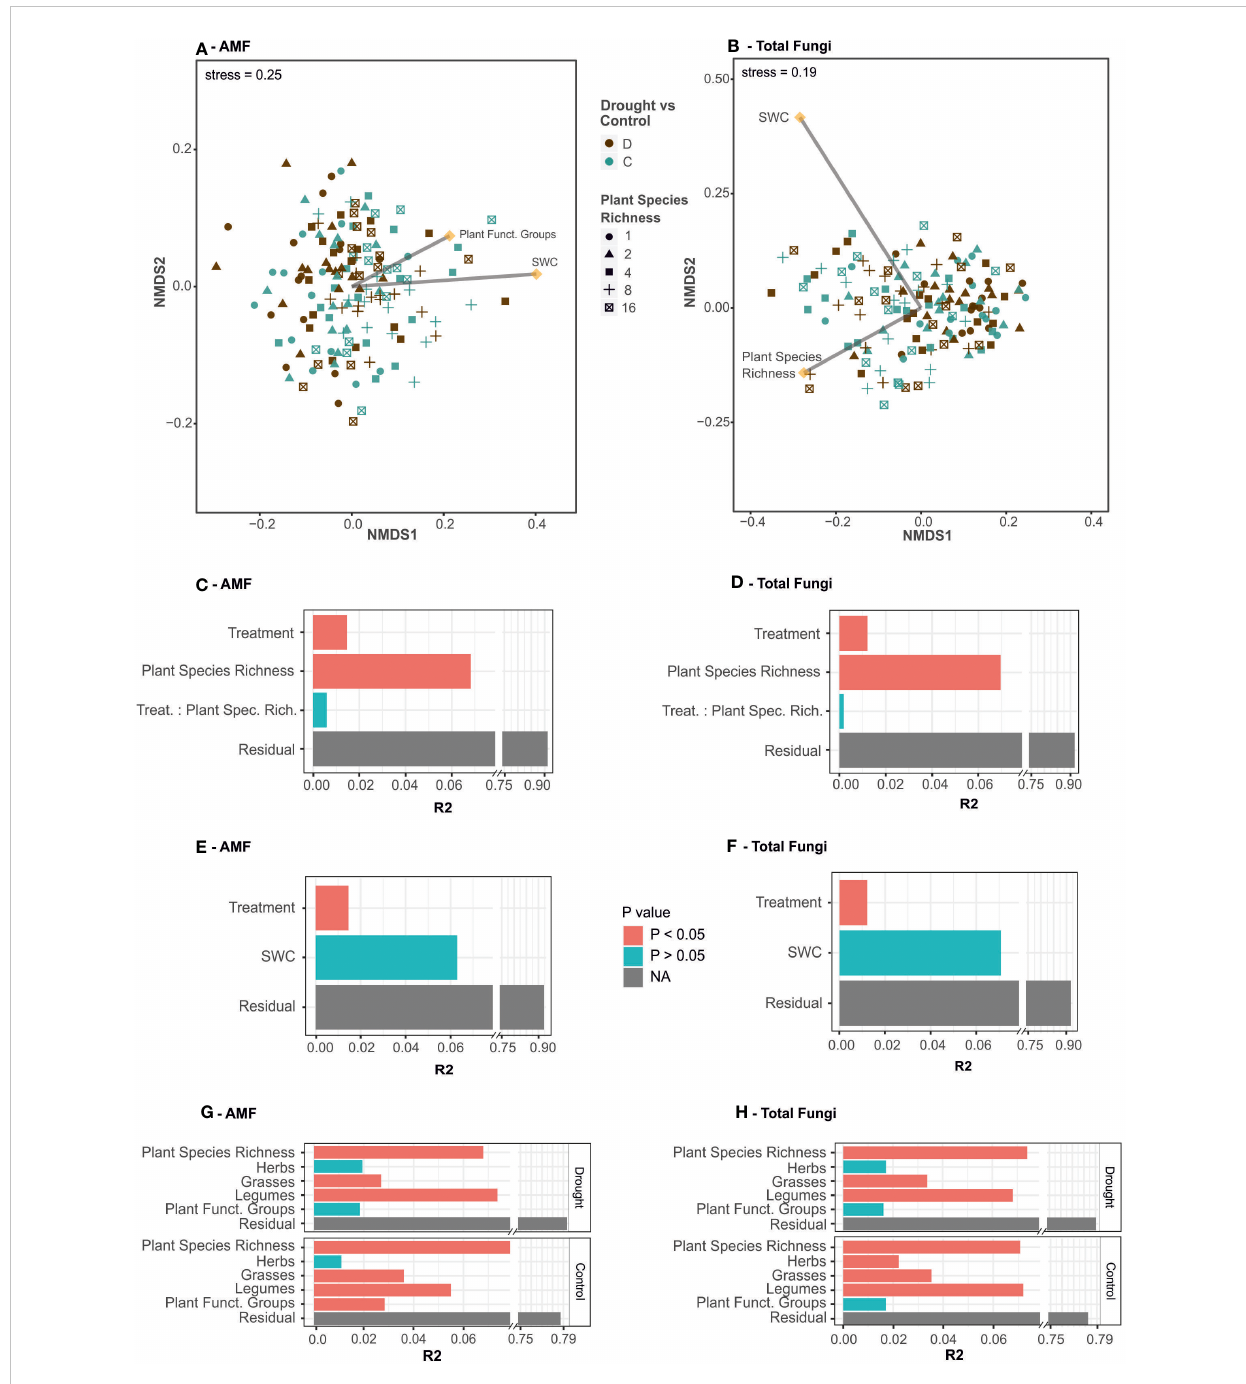
FIGURE 1 Effects of drought treatment, soil water content, and plant community composition on AMF and total fungal community composition. Non-metric multidimensional scaling of Jensen-Shannon dissimilarities for (A) AMF and (B) total fungal communities. Drought treatment is displayed by color (drought – brown, control – teal) and plant species richness by shape (1 – circle, 2 – triangle, 4- square, 8 – cross and 16 species – crossed square). Environmental factors fi tted with env fi t are indicated with arrows. Distance matrices were tested with PERMANOVA against effects of drought treatment and plant sown species richness and their interaction (C, D) , and effects of drought treatment and SWC (E, F) and plant community composition (G, H) . PERMANOVA results are displayed as R2 value and p value (red – signi fi cant, blue – non-signi fi